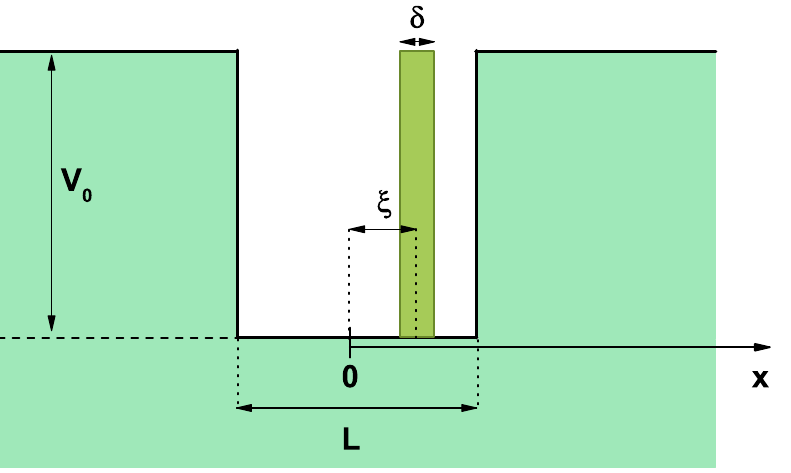
Figure 1. Schematic view corresponding to a quantum well of height V 0 and width L at the center of the x -axis origin. The doped delta layer of δ width located at a ξ distance from the origin of the coordinates is shown in dark